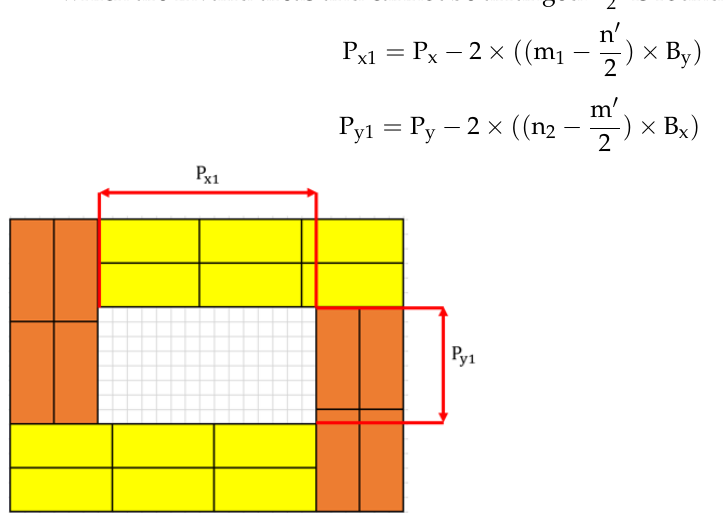
Figure 11. The area after calculation when Block 1 and Block 3 are non-overlapped.